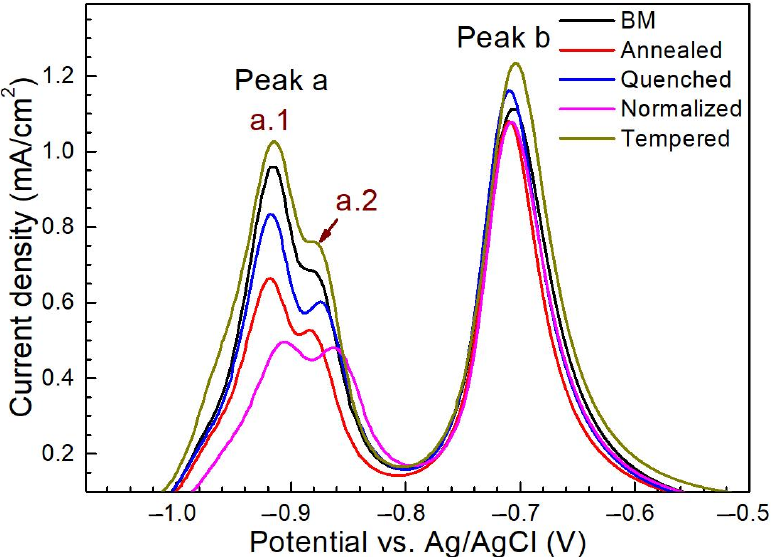
Figure 9. The first CV scans for the steels with different states after hydrogen charging for 30 min in NaOH solution containing